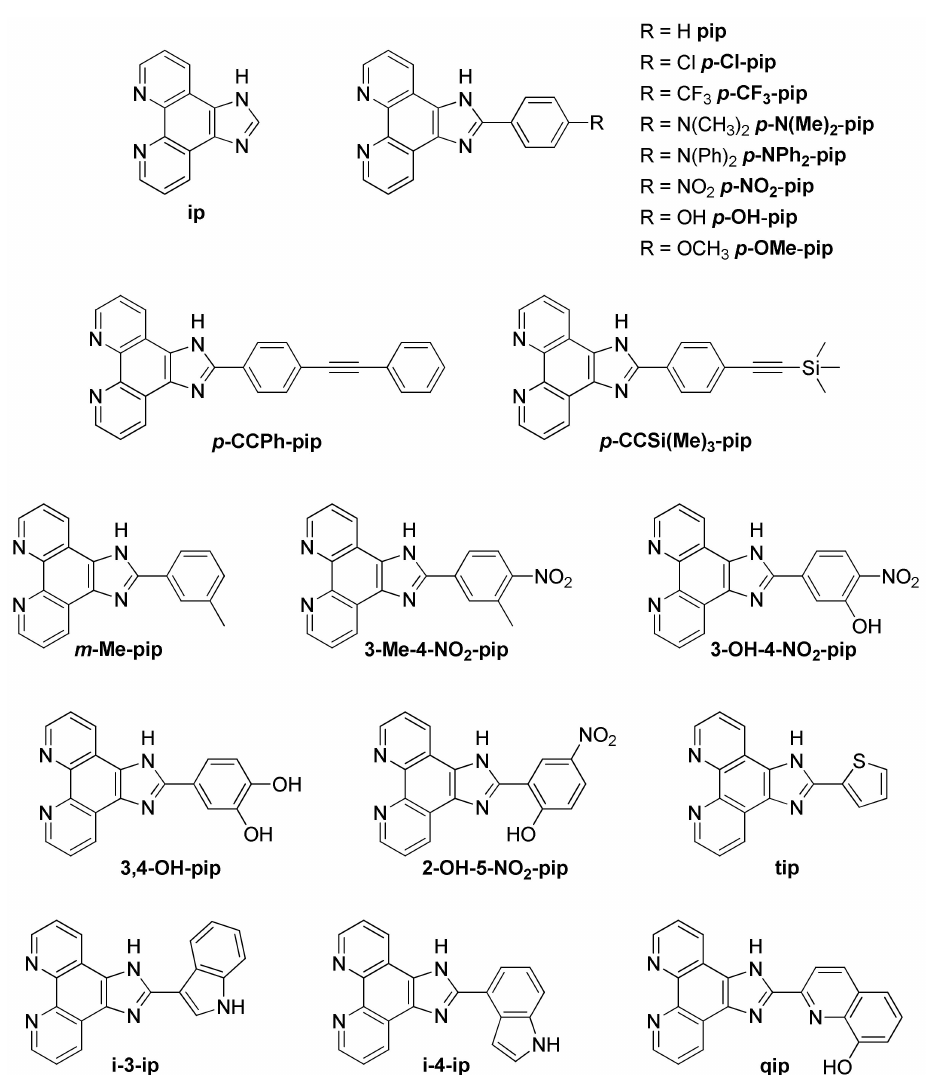
Figure 20. Structure of the imidazo-phenanthroline (ip) ligands and other closely related complexes used to form ruthenium(II) complexes studied in presence of